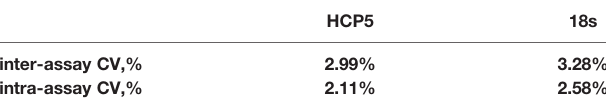
TABLE 1 | Intra- and inter-assay reproducibility of HCP5 and 18S rRNA.